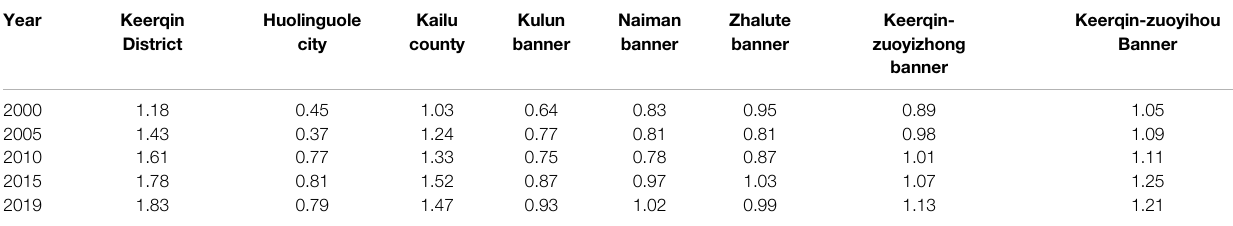
TABLE 2 | Ecological ef fi ciency of grass-based livestock husbandry in counties of Tongliao. Year Keerqin District